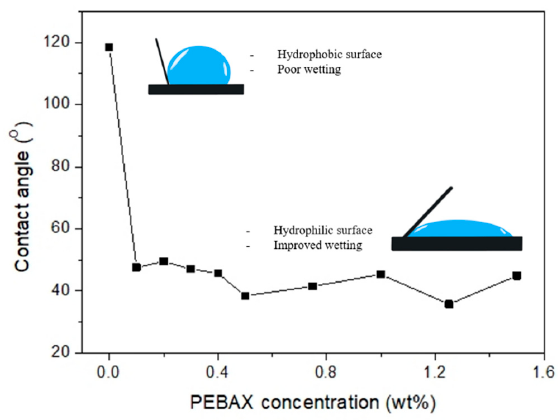
Figure 4. Effect of PEBAX concentration on contact angle.